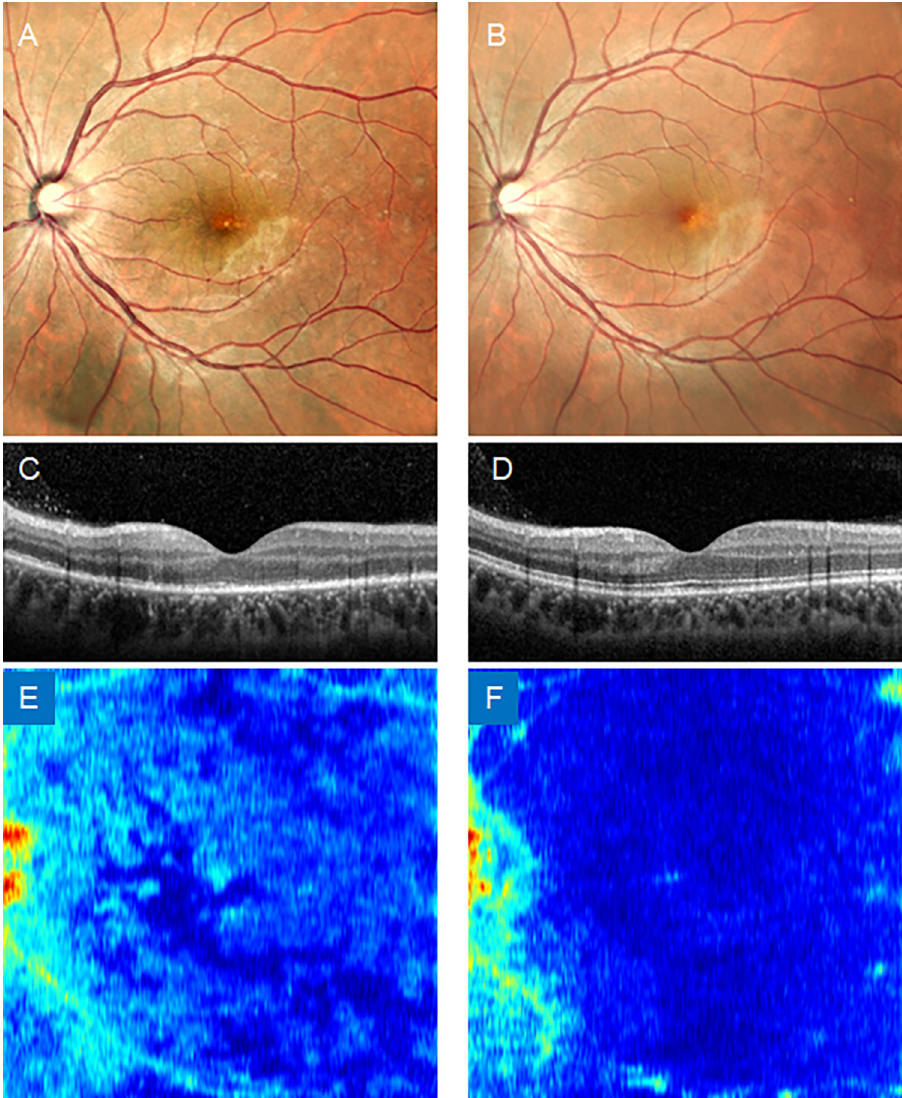
Fig 9. Ocular findings of case 3. Color fundus photographs at the first visit (A) and after 3 months (B). B-scan OCT image at the first visit (C) and after 3 months (D). EZ level Amb-I heatmap image at the first visit (E) and after three months (F). Amb-I: ambiguity index; EZ: ellipsoid